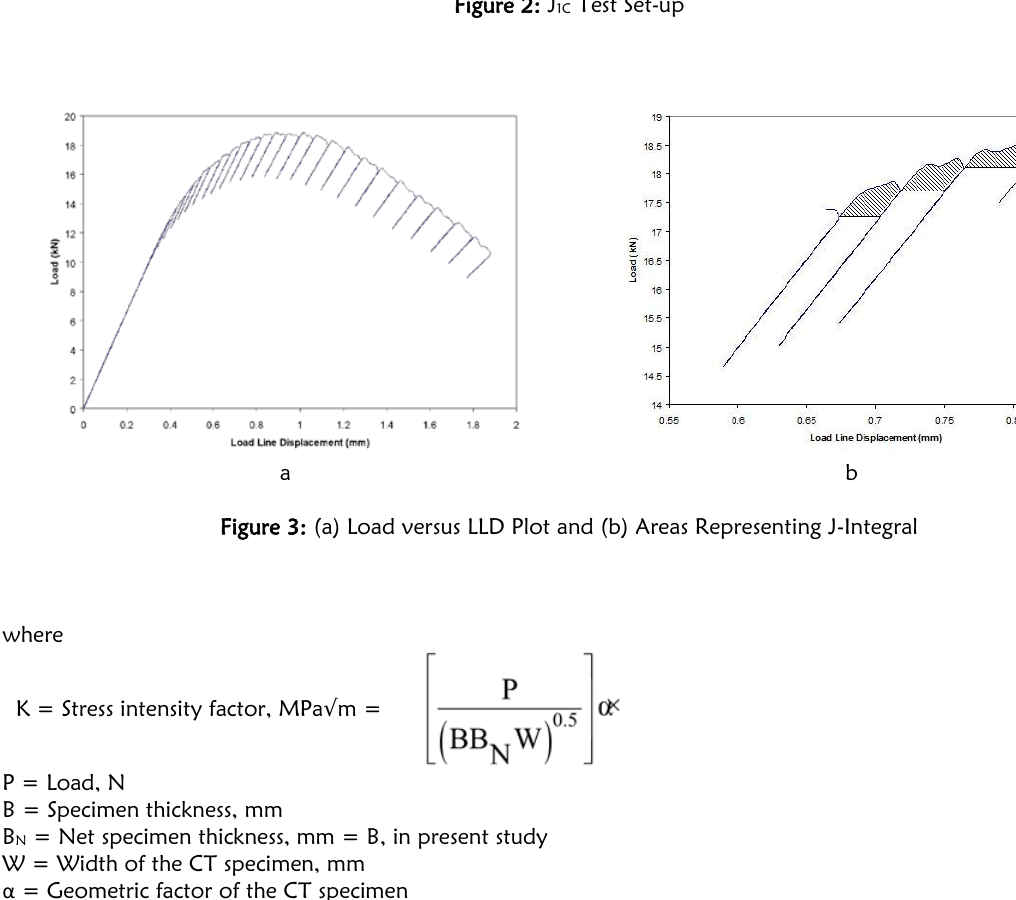
Figure 2: J 1C Test Set-up